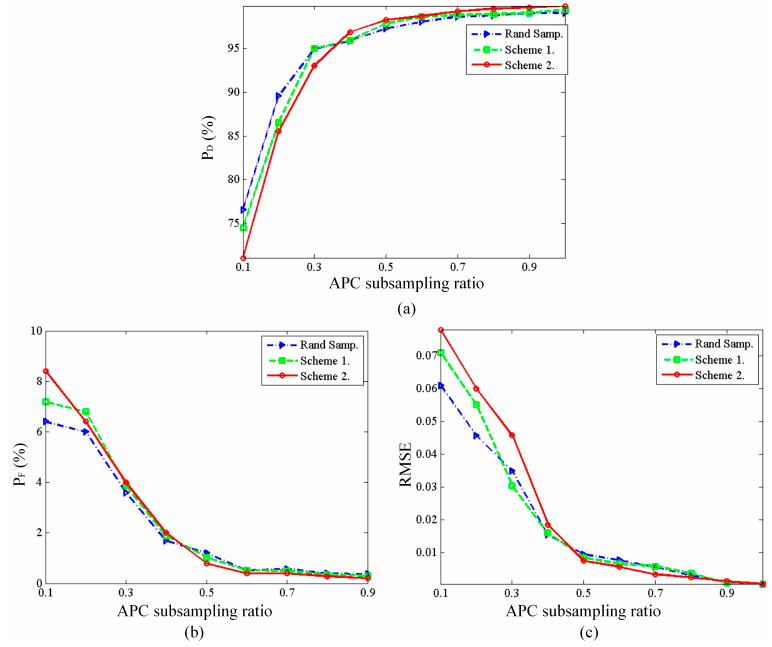
Figure 4. Reconstruction performance by different APCs’ configurations schemes: ( a ) probability of detection vs. APC subsampling ratio; ( b ) probability of false alarm vs. APC subsampling ratio; ( c ) RMSE vs. APC subsampling ratio.